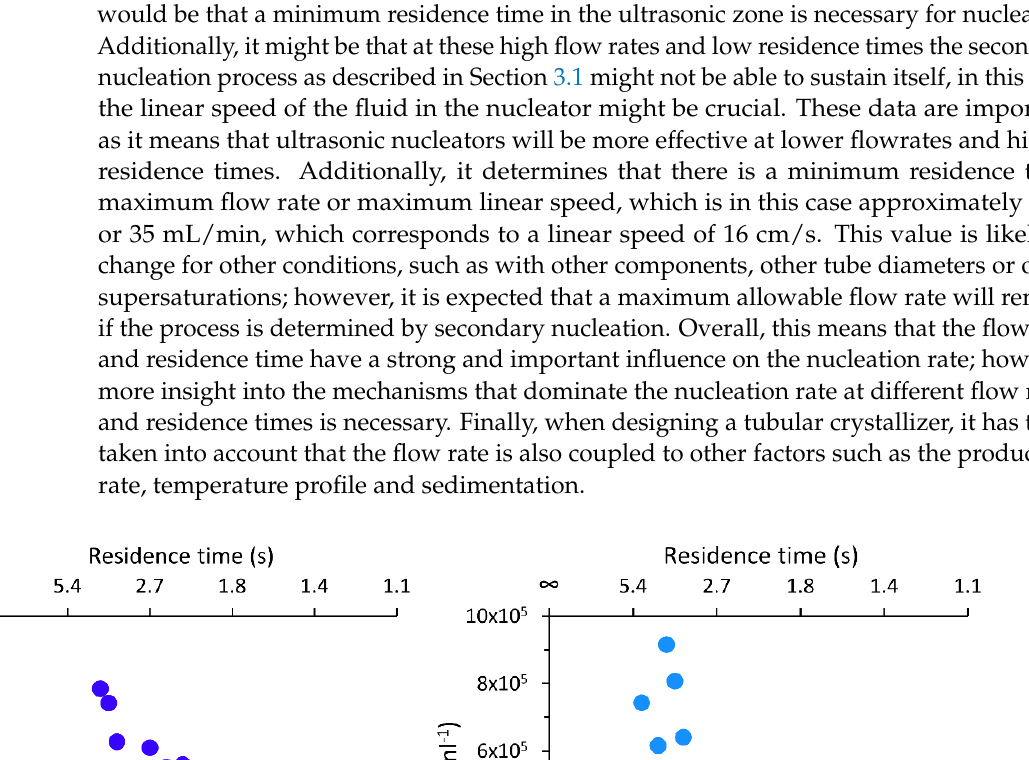
( b ) Figure 7. Nucleation rate in function of ( a ) the ultrasonic amplitude, and ( b ) the calorimetric ultrasonic power.